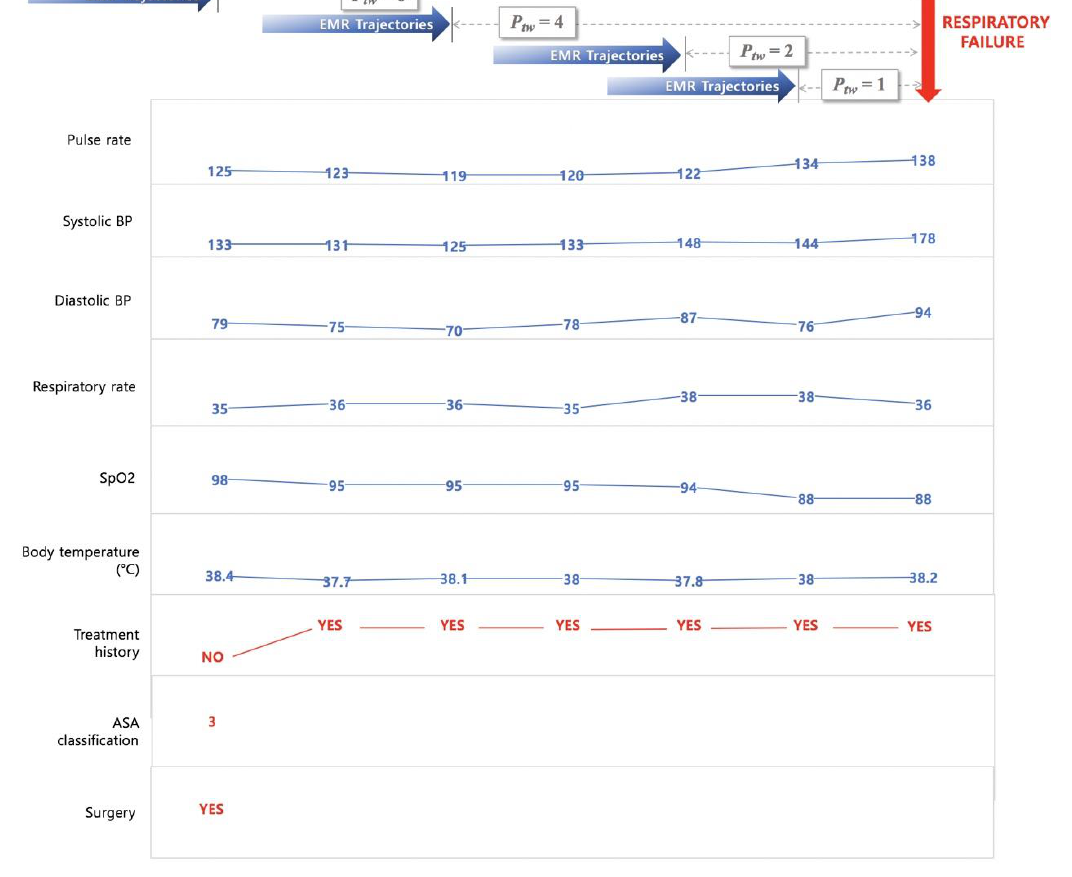
Figure 2. Sample trajectories of patient with acute respiratory failure. P tw = prediction time window; ASA = American Society of Anesthesiologists; EMR = electronic medical record; BP = blood pressure; SpO 2 = peripheral oxygen saturation.